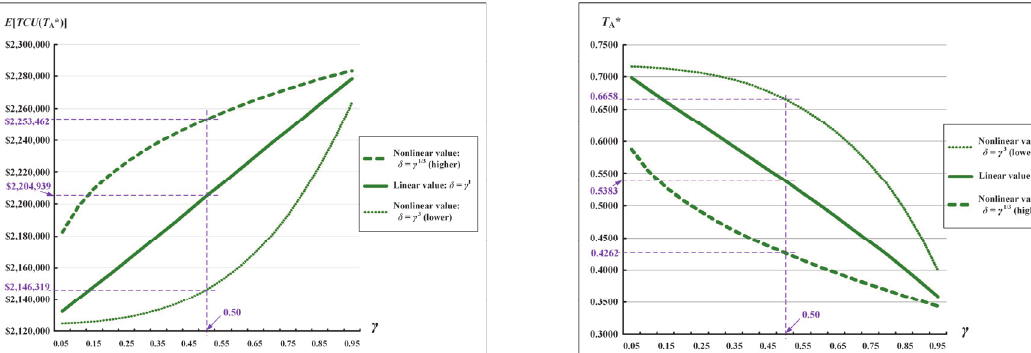
Fig. 9. The effect of different relationships between  and  on E [ TCU ( T A *)]